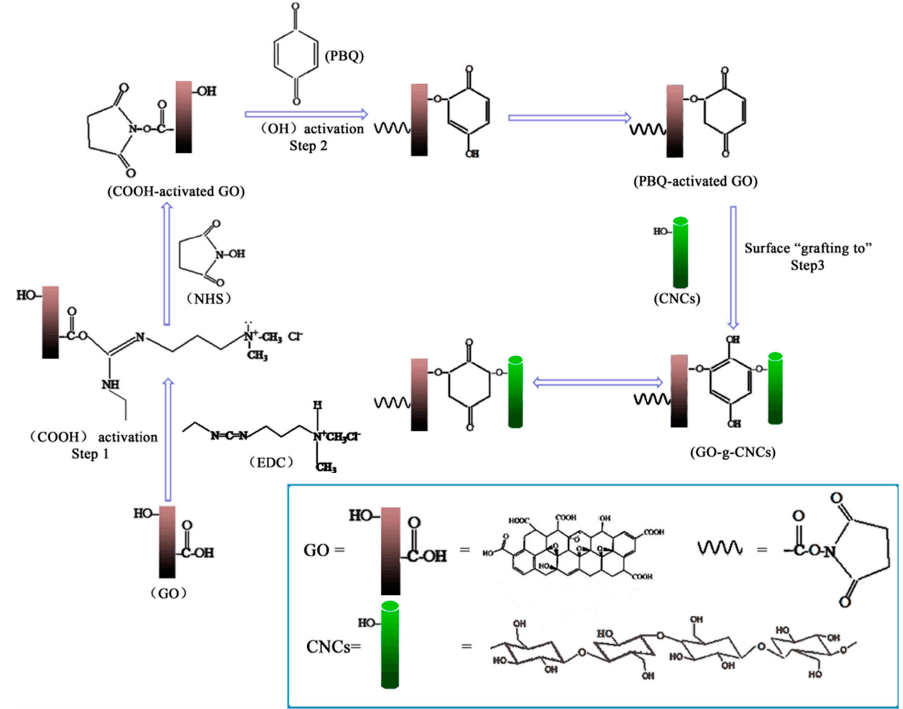
Figure 10. Schematic procedure of the preparation of the magnetic@GO-grafted-CNC@MIP. Figure10. Schematicprocedureofthepreparationofthemagnetic@GO-grafted-CNC@MIP.Reproduced Reproduced with permission from Reference [163]. Copyright ©2017, Springer. with permission from Reference [163]. Copyright © 2017,